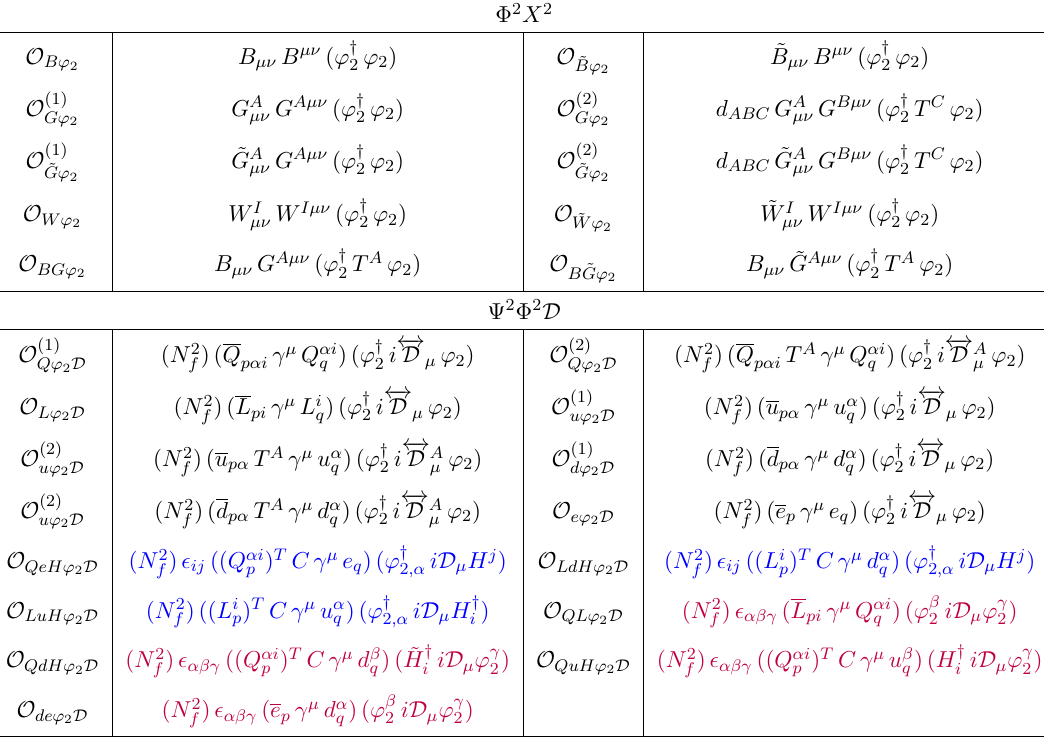
Table 39 . SM extended by Lepto Quark ( ϕ 2 ): additional operators of dimension 6. Here i, j and α, β, γ are the SU(2) and SU(3) indices respectively. T A are the SU(3) generators. A, B, C = 1 , 2 , · · · , 8 and I = 1 , 2 , 3 . p, q = 1 , 2 , · · · , N f are the flavour indices. Operators in red violate lepton and baryon